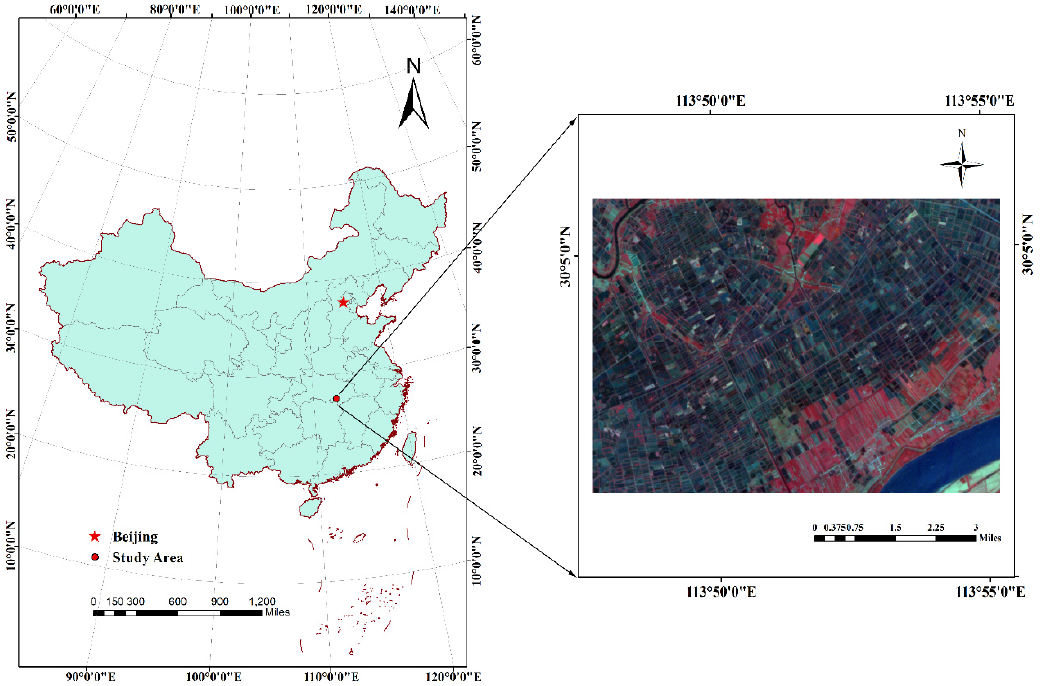
Figure 1. Location of the study area ZhuHai-1 (ZH-1) image shown on the right side of this figure with false color composite: R = near infrared, G = red, B = green).